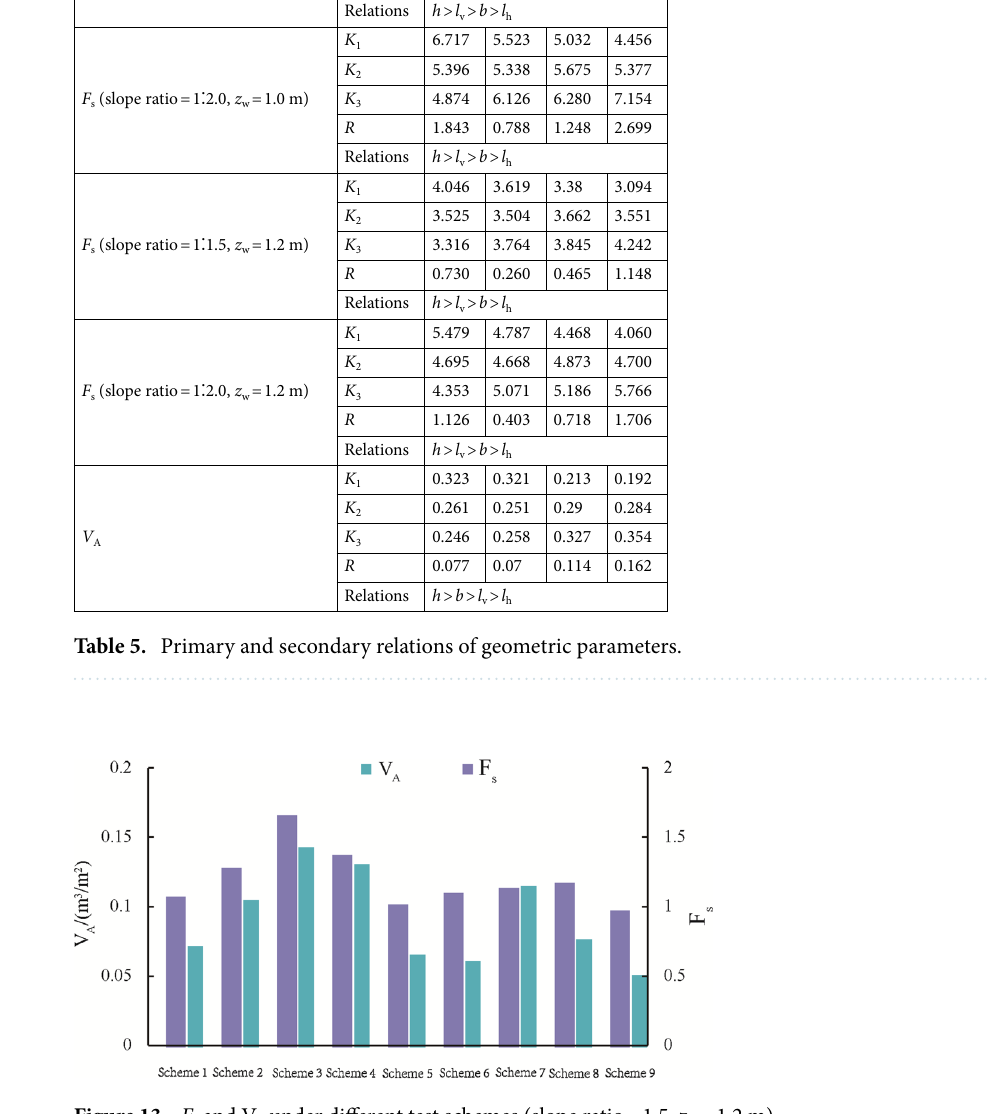
Figure 13. F s and V A under different test schemes (slope ratio = 1.5, z w = 1.2